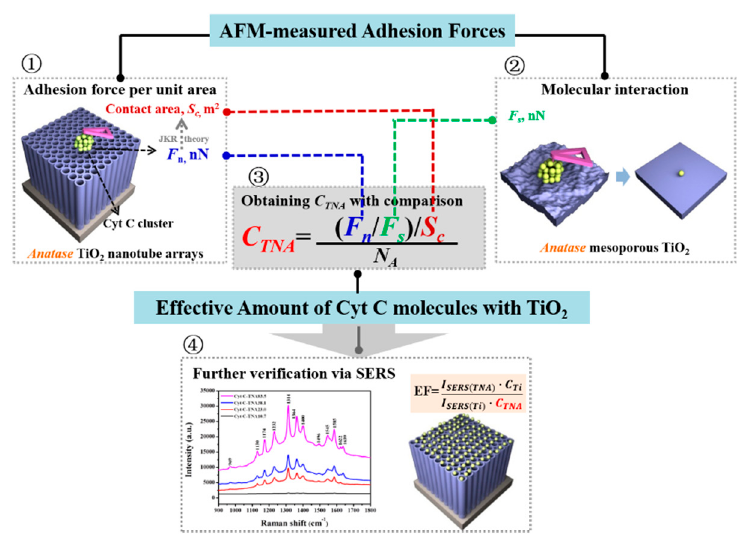
Figure 8. Scheme of the procedure for determining the effective amount of Cyt c molecules interacting with TiO 2 nanotube arrays ( ③ ) by AFM-measured adhesion forces ( ① ) and molecular force ( ② ), and further verification by SERS and the calculated EF ( ④ ). Reprinted from Ref. [110] with permission from Elsevier.